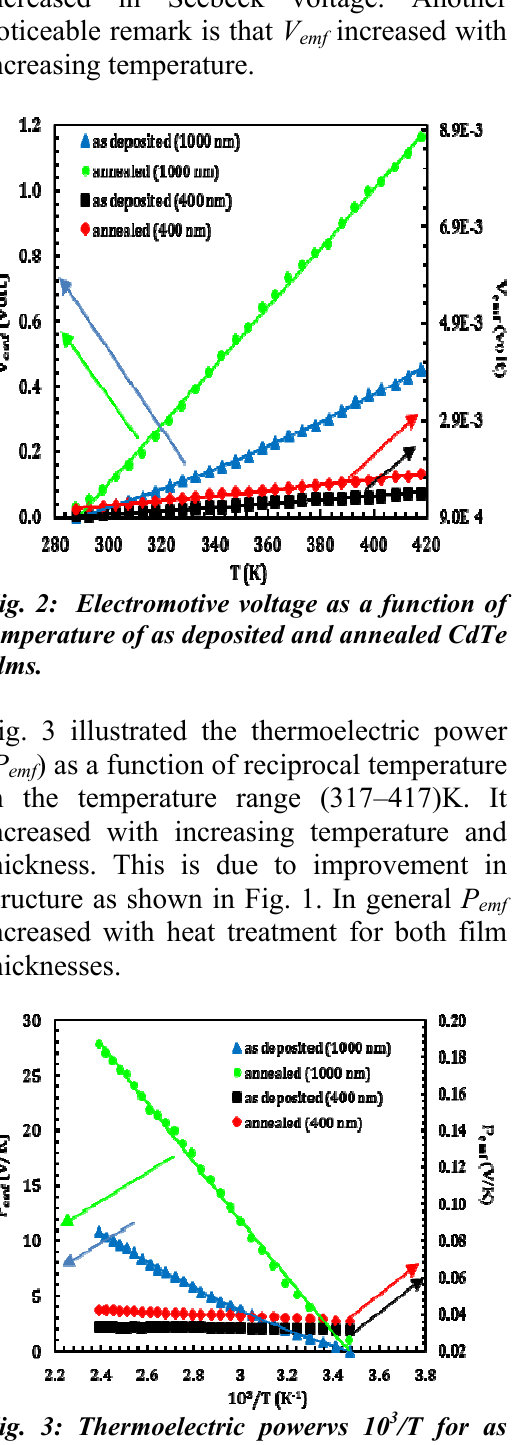
Fig. 3: Thermoelectric powervs 10 3 /T for as deposited and annealed CdTe films.